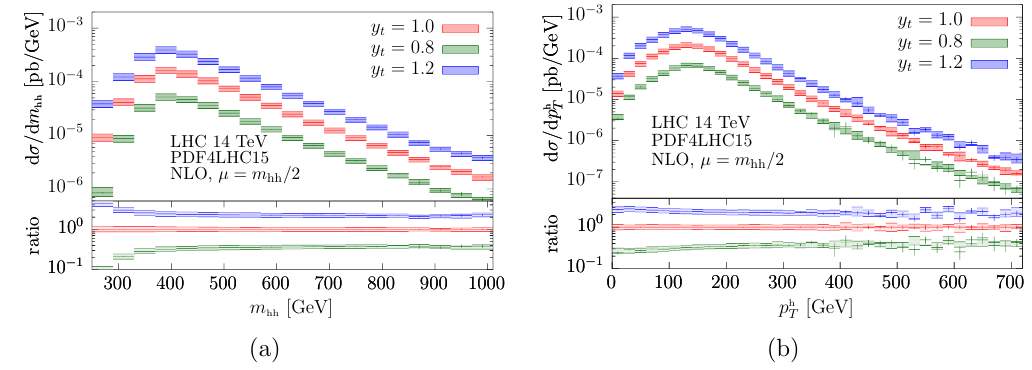
Figure 4. Higgs boson pair invariant mass distributions, and distributions of the transverse momentum of one (any) Higgs boson for non-SM values of the top quark Yukawa coupling y t at p s = 14 TeV, including scale uncertainties.